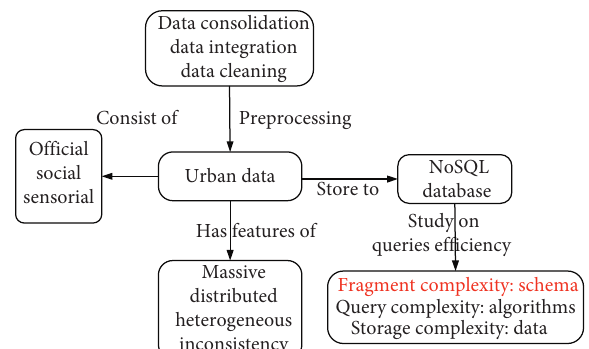
Figure 1: Example of a double-array